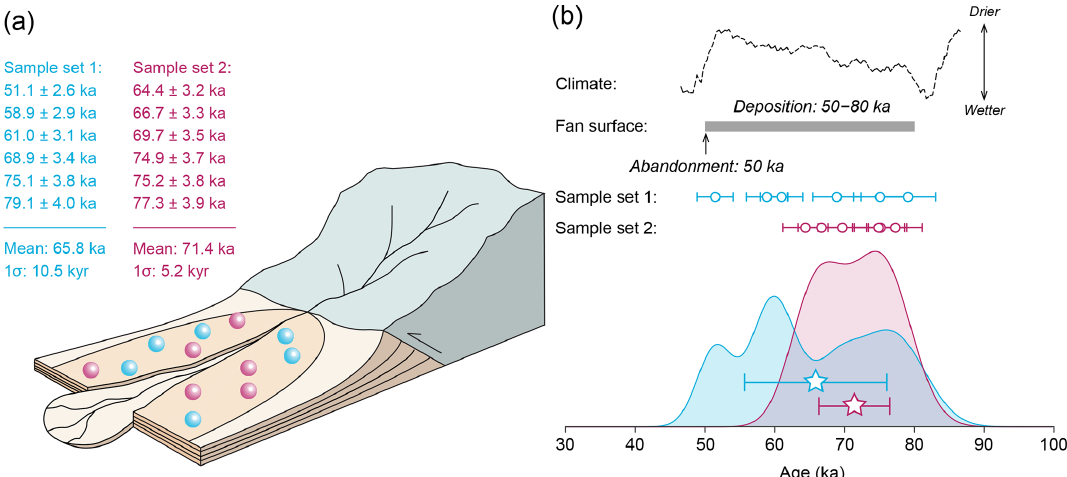
Figure 1. (a) Conceptual alluvial-fan surface that was formed over a 30kyr period, from 80 to 50ka, after which it was abandoned, e.g. due to incision. Two different dating scenarios (sample sets 1 and 2) are shown in which six surface ages are randomly selected. (b) The true period of surface activity (grey bar) compared with the sampled ages presented as data points (circles), kernel density plots, and mean surface ages ± 1 standard deviation (stars). A hypothetical climate scenario is depicted as a dotted